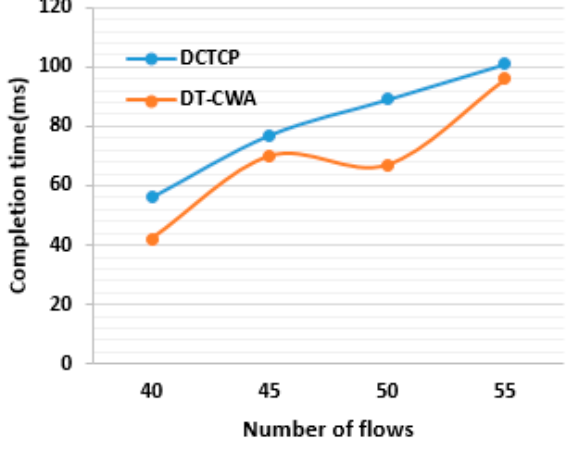
Figure 8. Comparison of average short message completion time.